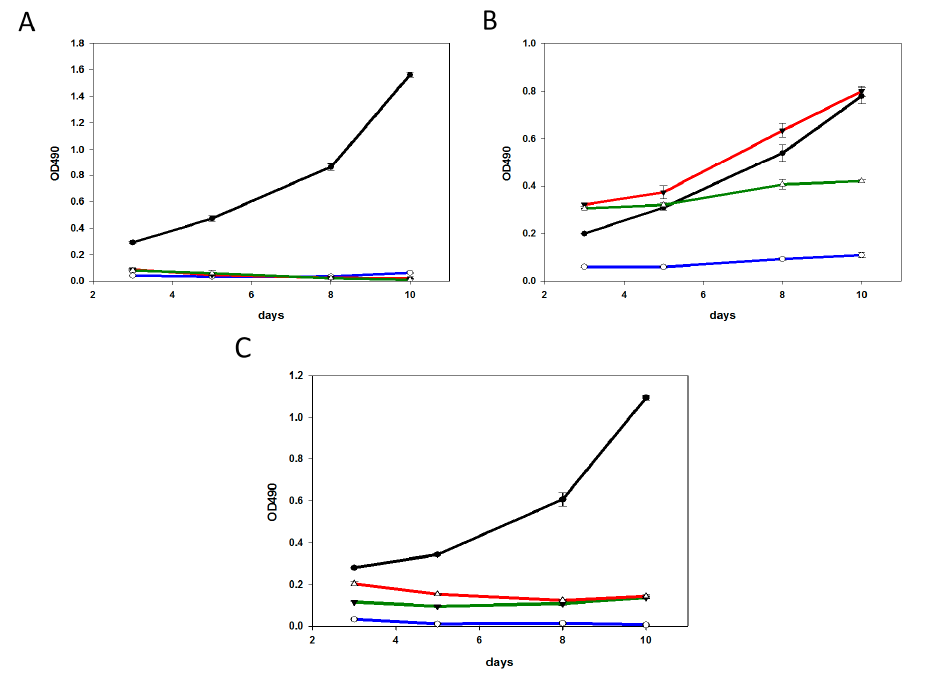
Figure 3. Growth profiles of SK-BR-3 ( A ); HCC1419 ( B ); or BT-474 ( C ) cells surviving deB-C6.5-diab (blue), T-DM1 (red), T-MMAE (green) treatments, or untreated cells (black). Untreated cells or cells surviving deB-C6.5-diab, T-DM1, and T-MMAE treatments were harvested and recultured without drugs. Cell growth was measured as O.D. 490 using the Cell Titer 96 Aqueous One solution